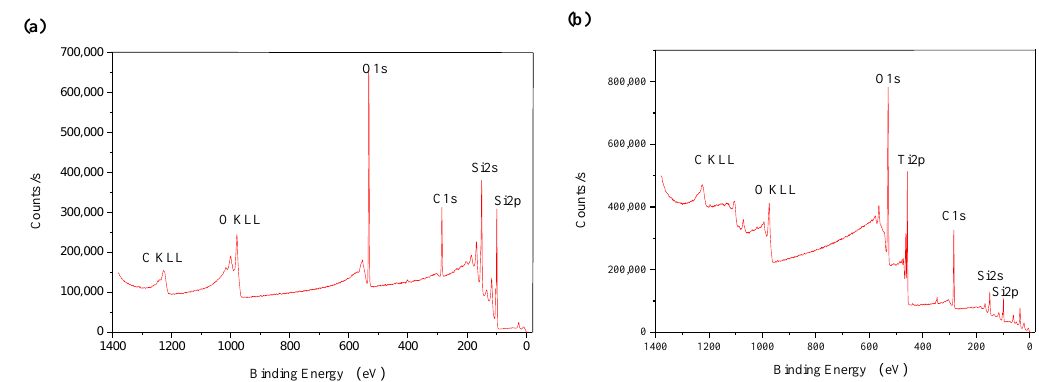
Figure 13. Full spectrum of ( a ) XPS of the original Si surface; ( b ) XPS of Si surface after TiO 2 nanoparticle colloid jet impacting under ultraviolet irradiation.